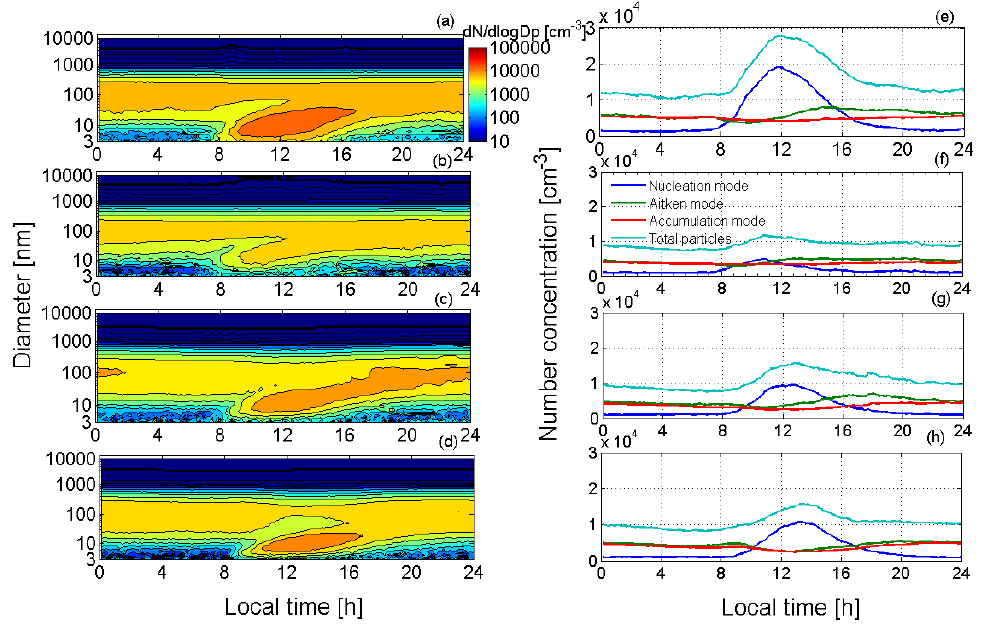
Fig. 3. Mean diurnal variations of the particle number size distributions (left) and number concentrations in different modes (right) in spring (a) , (e) , summer (b) , (f) , fall (c) , (g) and winter (d) , (h).